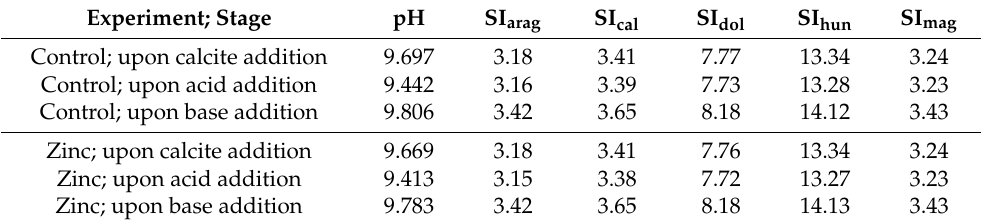
Table 1. Values of pH and saturation index (SI) calculated using PHREEQC and the Pitzer database for geochemical equilibrium reactions at 43 ◦ C. Arag: aragonite; cal: calcite; dol: dolomite; hun: huntite; mag: